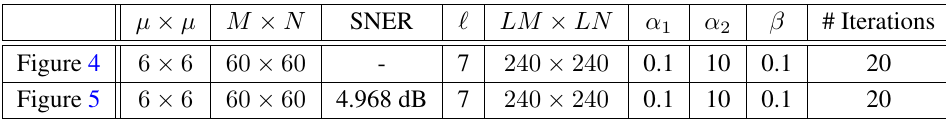
Table 2. Input parameters for simulated TOMBO images.